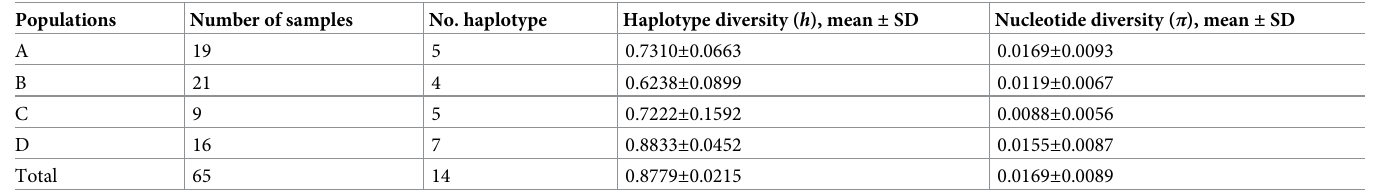
Table 2. Haplotype and nucleotide diversity of 4 populations of Cryptozona siamensis identified in Thailand and Malaysia, based on their mitochondrial 16S rRNA sequences. Populations Number of